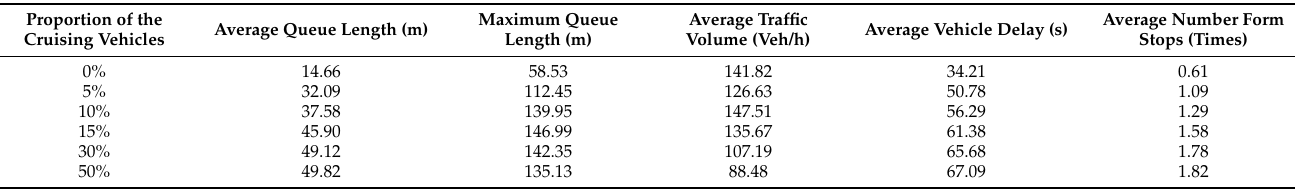
Table 3. Traffic flow status at the